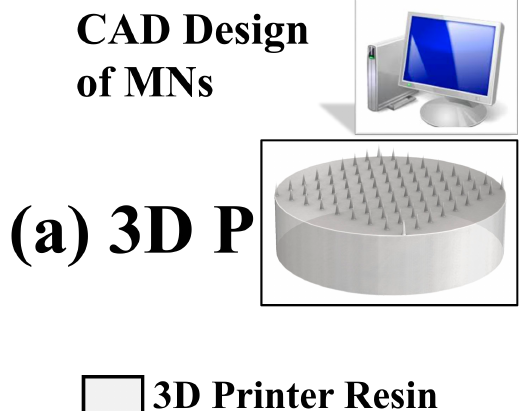
Figure 2. 3D design and fabrication of the microneedles targeted in this work involving only CAD design and 3D printing (3D P).